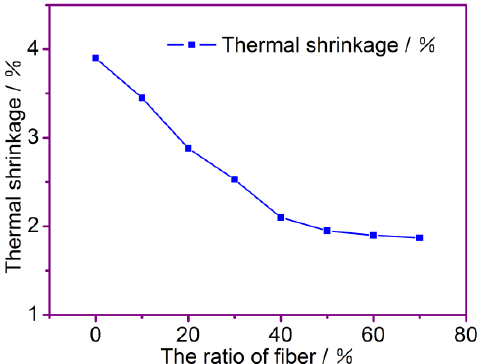
Figure 5. The effect of fiber ratio on thermal shrinkage at 160 ◦ C.